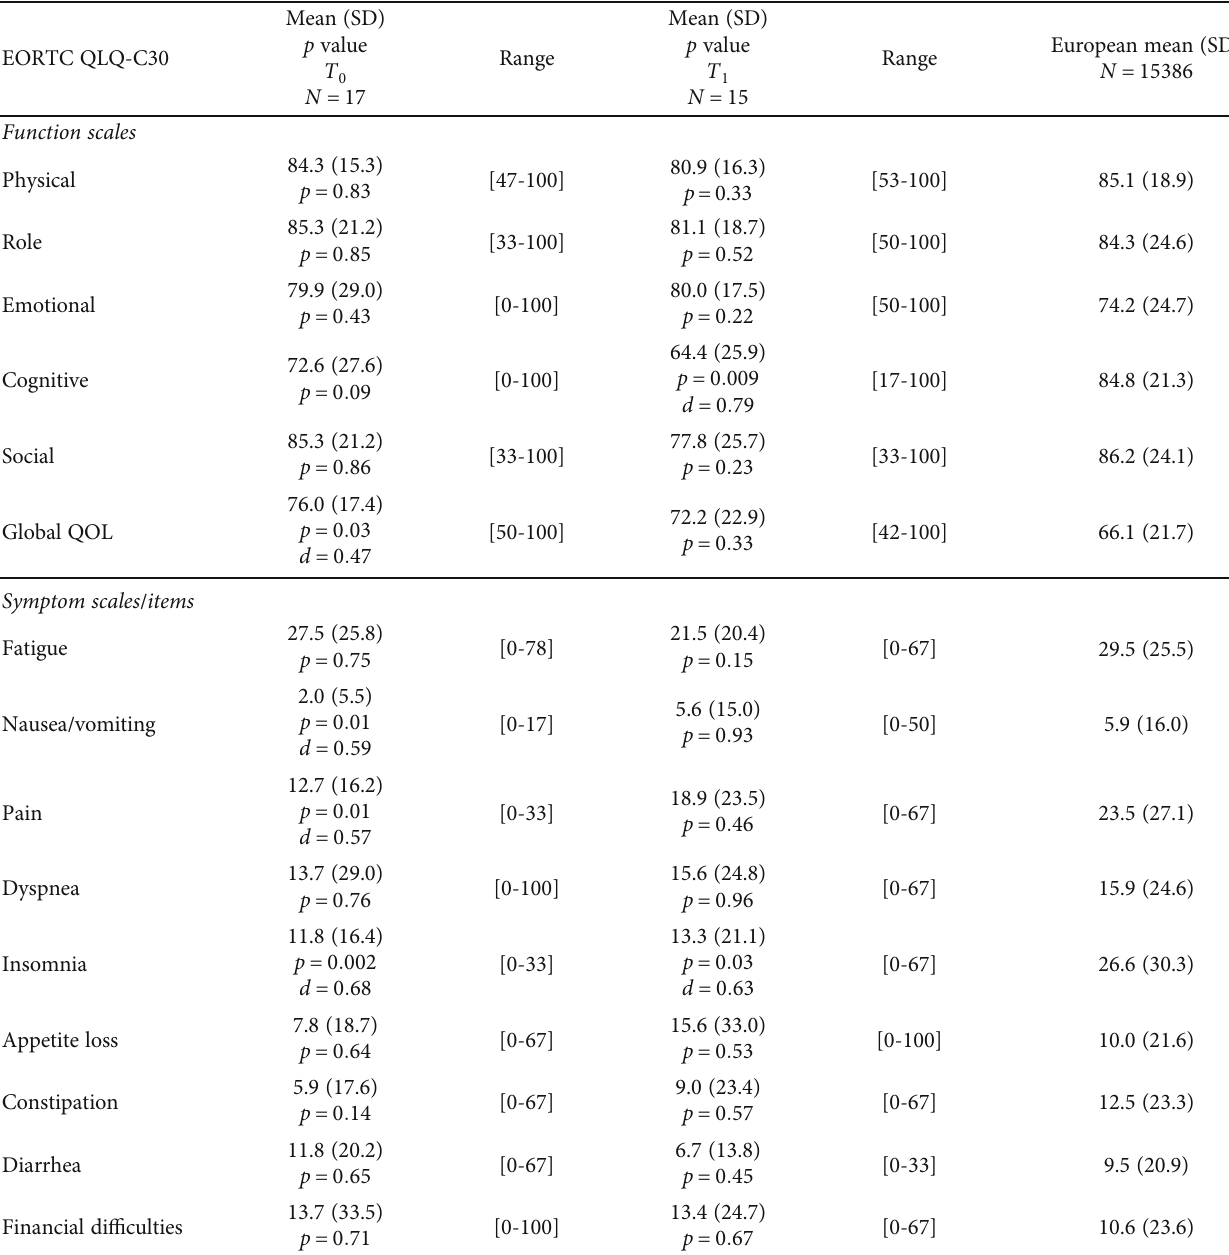
T 0 and 1 compared to the pooled European normative data [28].